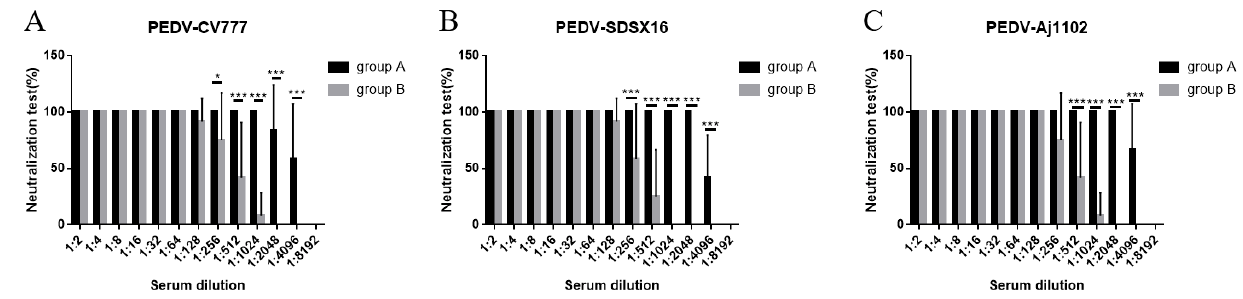
Figure 9. Neutralization of PEDV-CV777 ( A ), PEDV-SDSX16 ( B ), and PEDV-Aj1102 ( C ) by serum from piglets in groups A and B. Results are expressed as the mean values from triplicate wells. Data are shown as mean ± SEM (* p < 0.05, ** p < 0.01, *** p < 0.001).